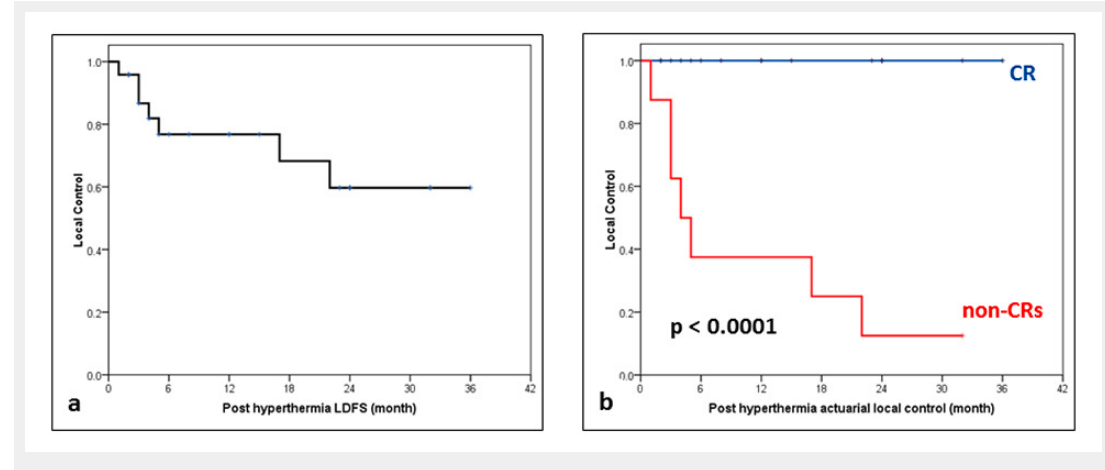
Figure 3 (a) Actuarial local control for all patients of recurrent breast cancers following reirradiation and hyperthermia. (b) Actuarial local control in complete responders (CRs) vs non-CRs (p <0.001). LDFS = local disease-free